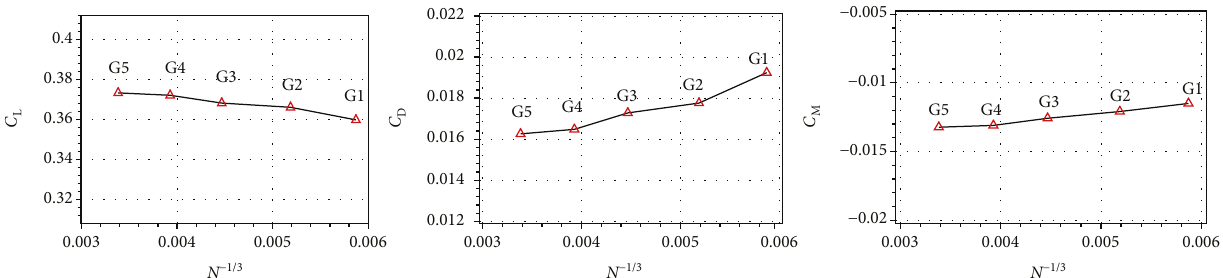
Figure 8: Aerodynamic forces for the powered con fi gurations of the fi ve levels of grids at 5 ° (low speed).